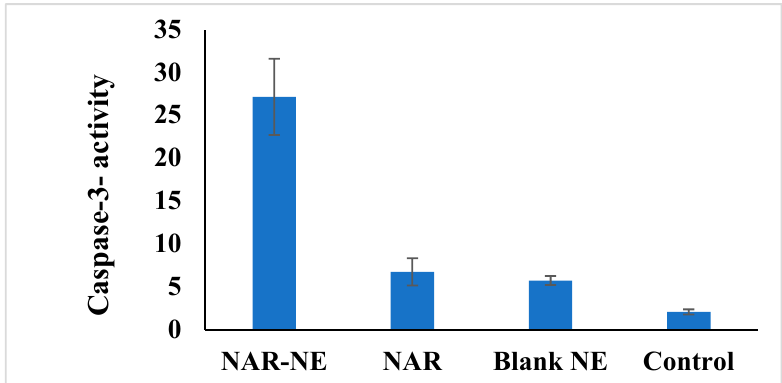
Figure 15. Effect of treatment with IC 50 concentrations of free NAR, blank NE, or NAR-NE on caspase-3 activity in A549 cancer cells ( p < 0.05 for free NAR vs. NAR-NE).